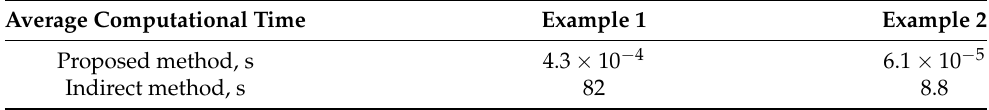
Table 6. Computational times of two